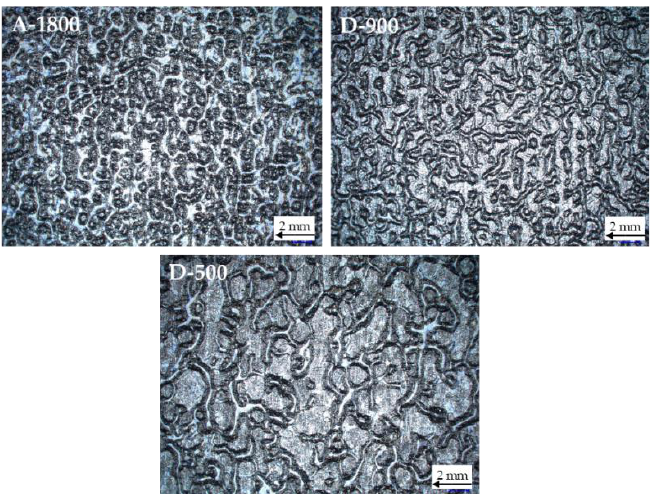
Figure 6. Topographic images of B-stage coated electrical steel sheets based on the epoxy adhesives A-1800, D-900 and